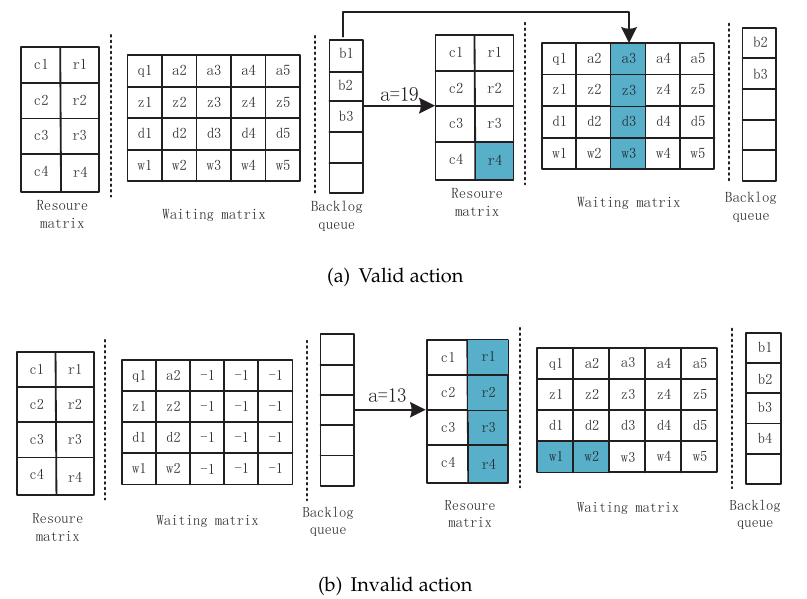
Figure 3. Illustration of the state transition with two examples of a valid action and an invalid